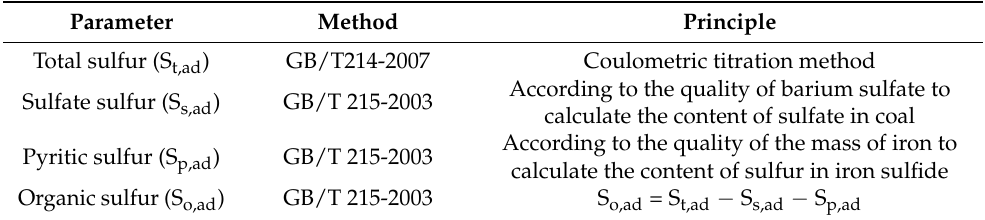
Table 1. Test method for total sulfur and forms of sulfur in